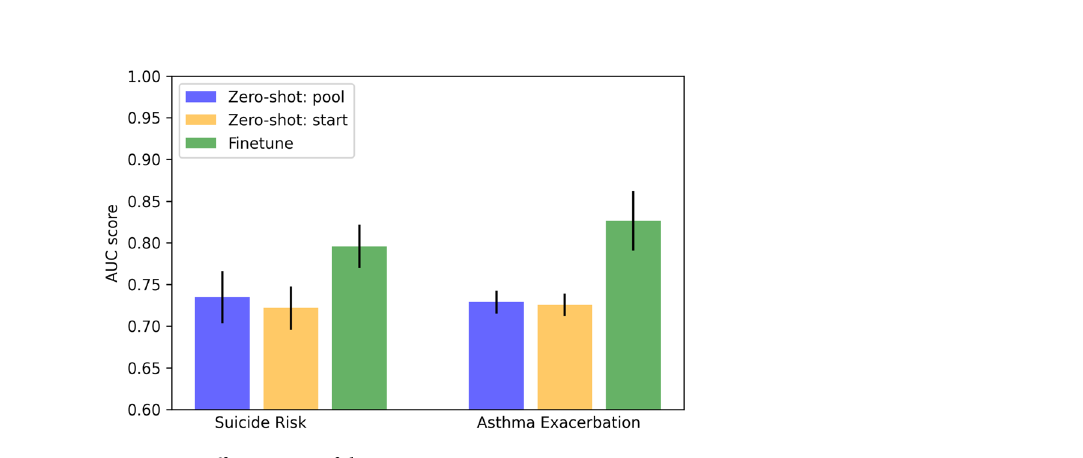
Table 3. Results on asthma exacerbation prediction task.